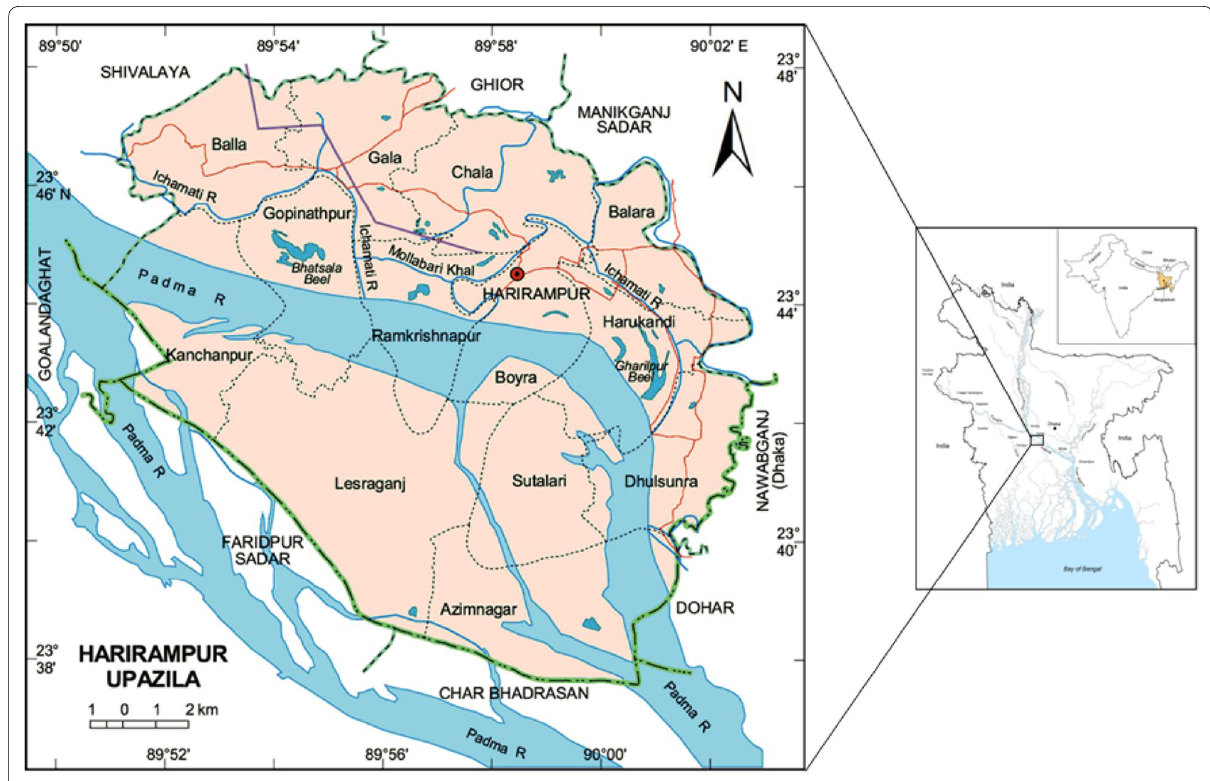
Fig. 1 Map showing the location of study